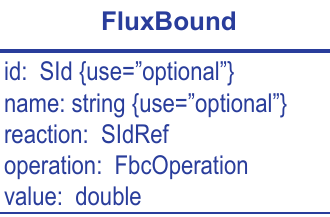
Figure 3: A UML representation of the Flux Balance Constraints package FluxBound class. See Section 1.4 for conven- tions related to this figure.